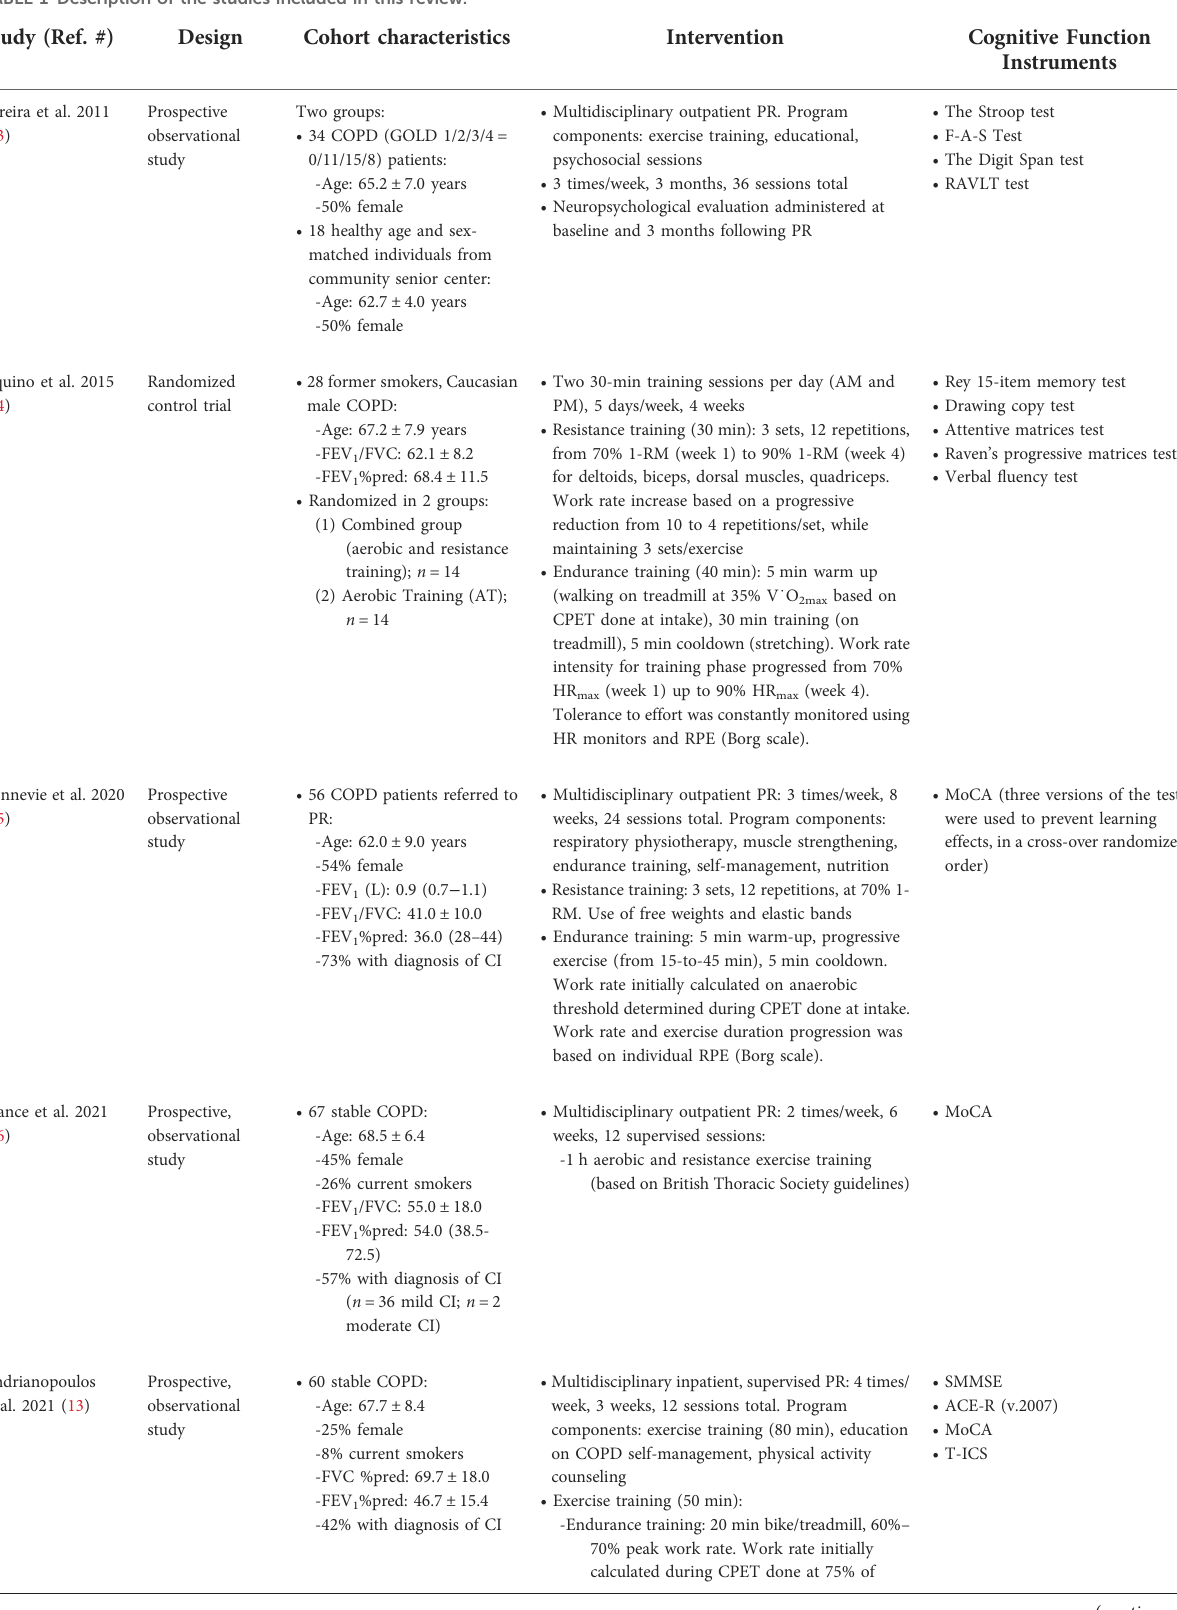
TABLE 1 Description of the studies included in this review. Study (Ref.